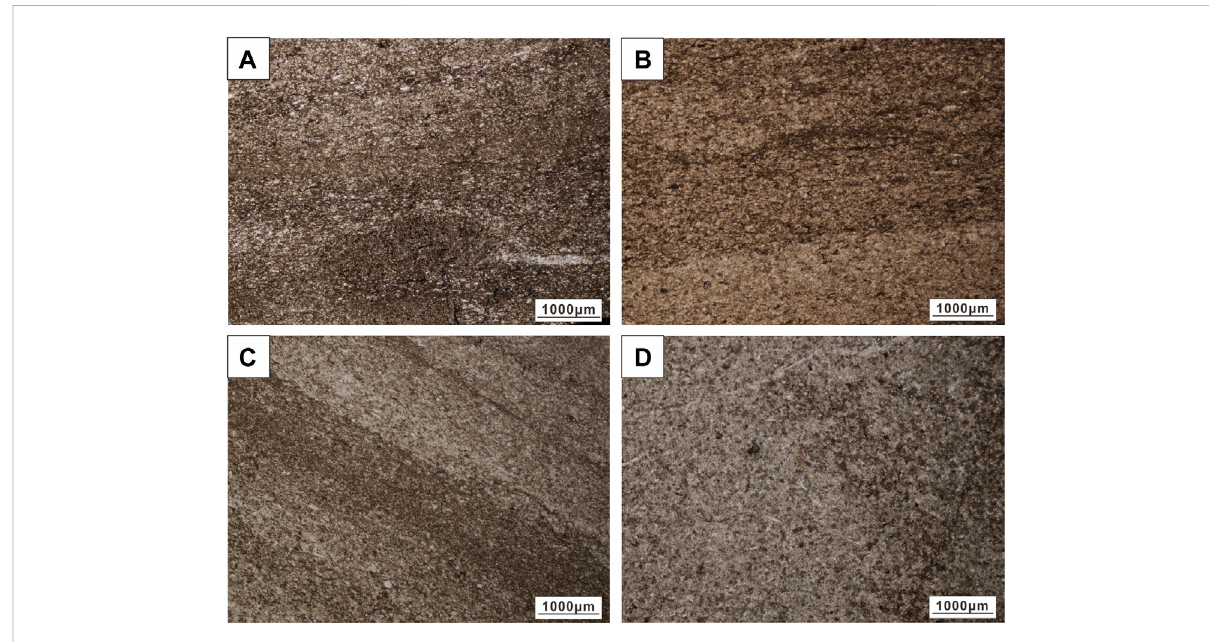
FIGURE 3 Photomicrographs of micritic to near-micritic carbonates. (A – D) : Samples DK-14, DK-32, DK-51, and